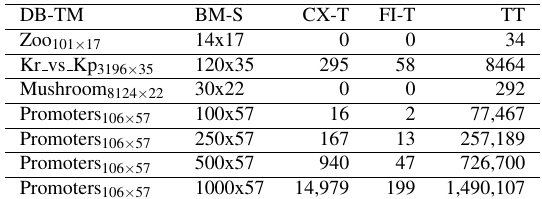
Table 4. Run time execution in seconds of several algorithms